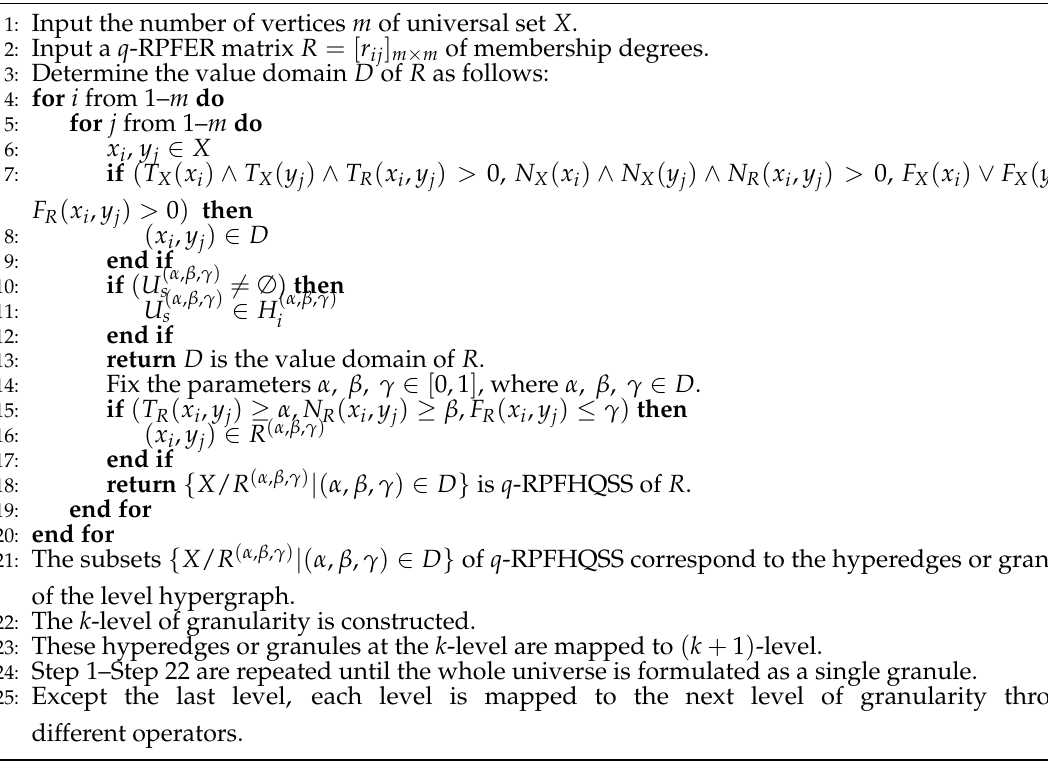
Algorithm 2 The bottom-up construction for level hypergraphs.